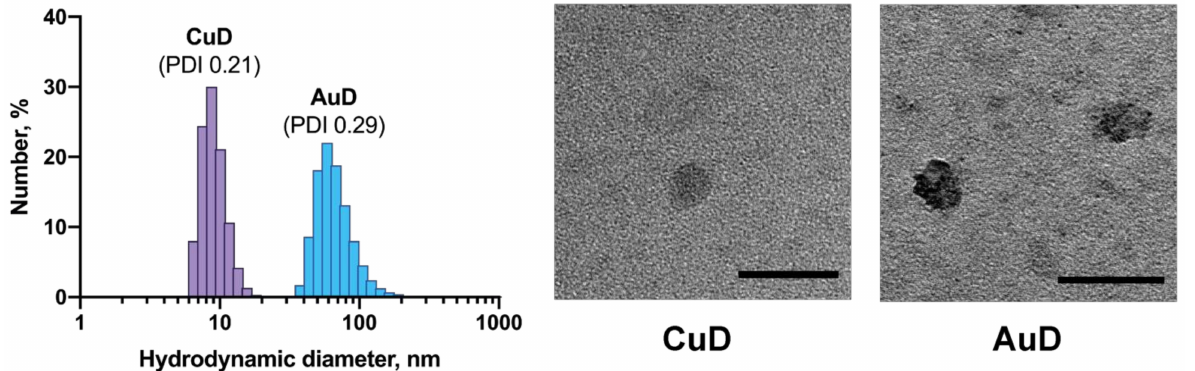
Figure 2. Particle size distribution in CuD and AuD solutions ( left ). TEM images of metallodendrons ( right ). Scale bar is 50